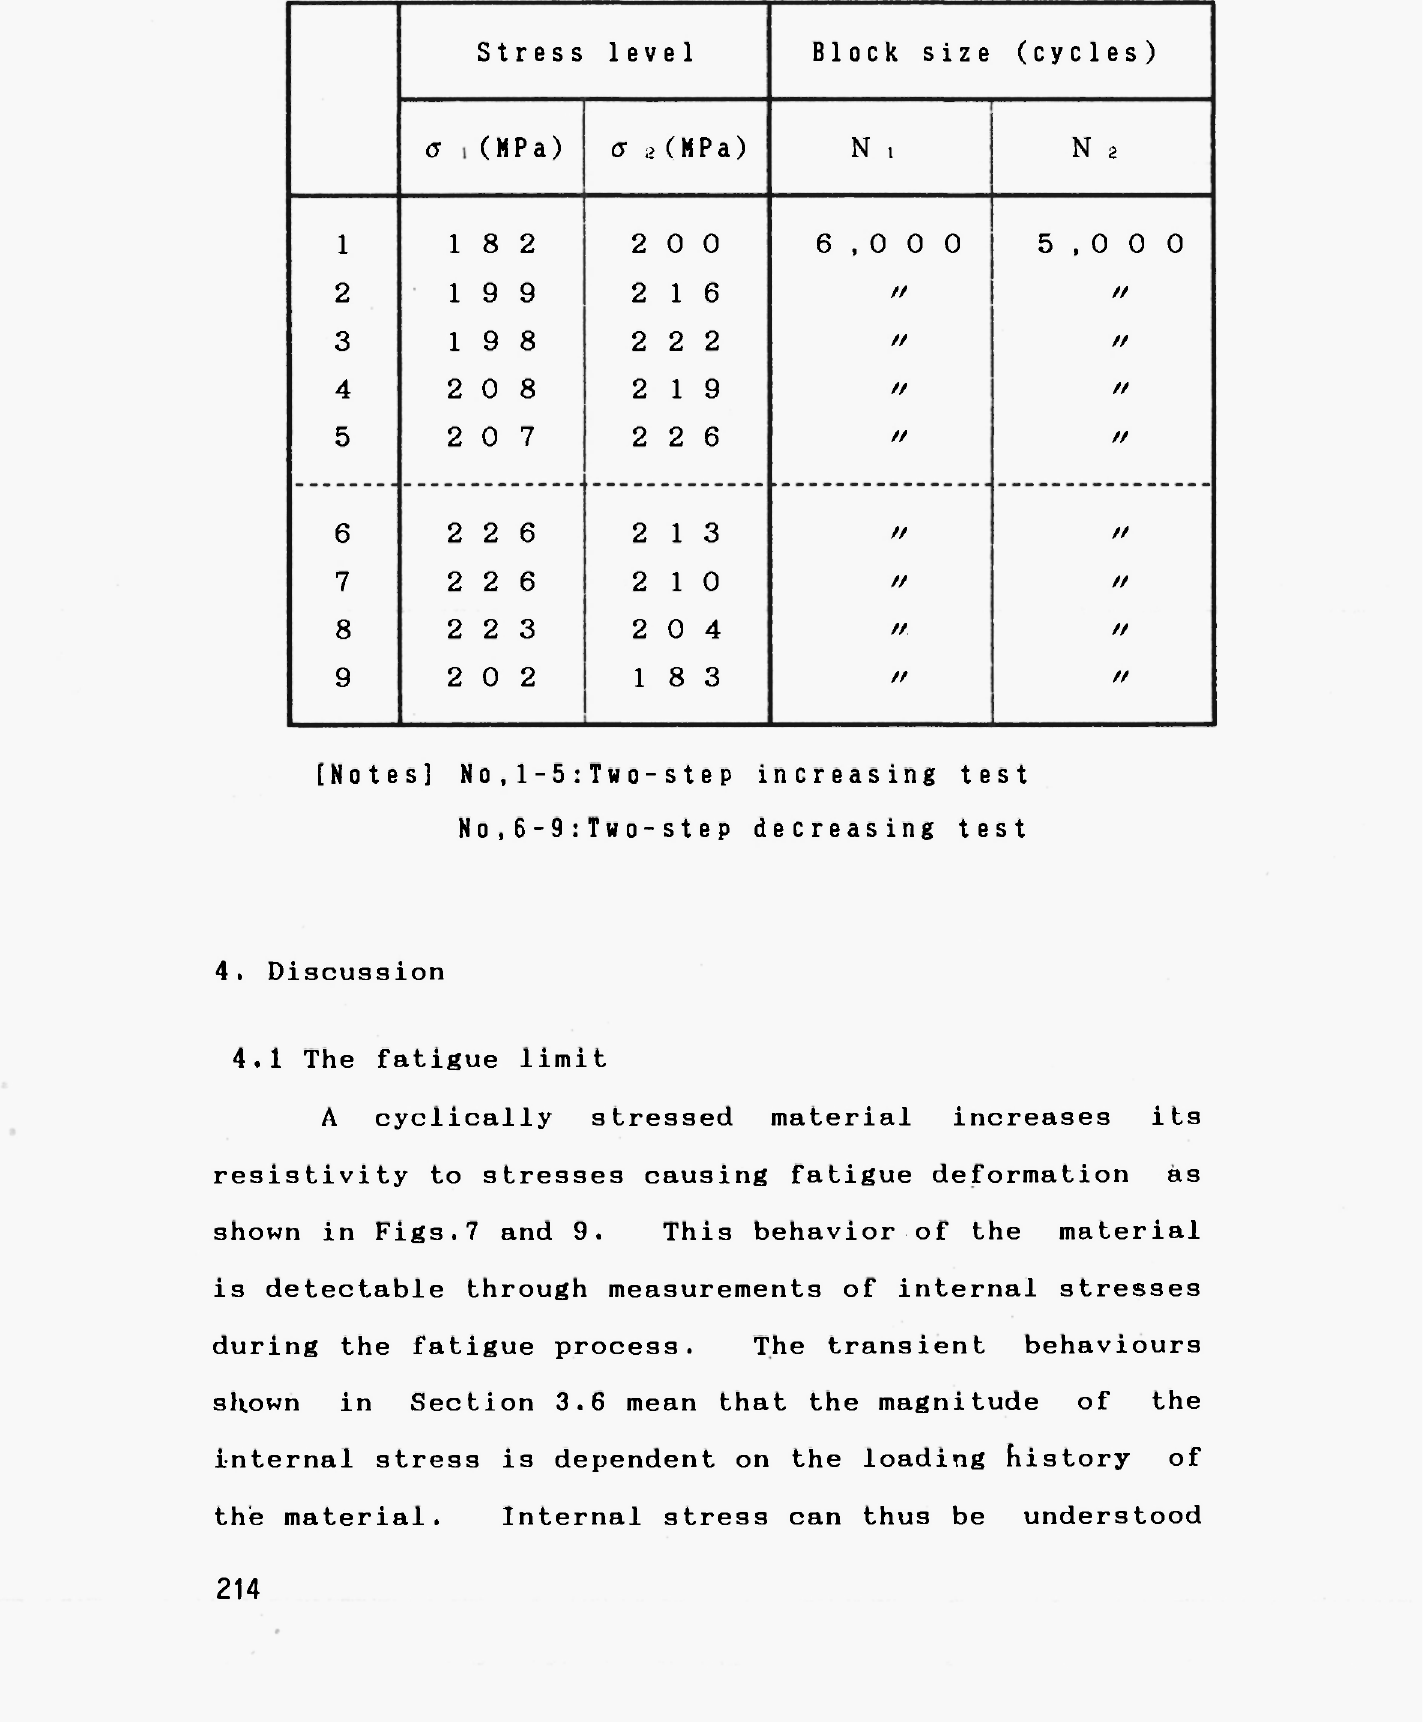
Stress level Block size